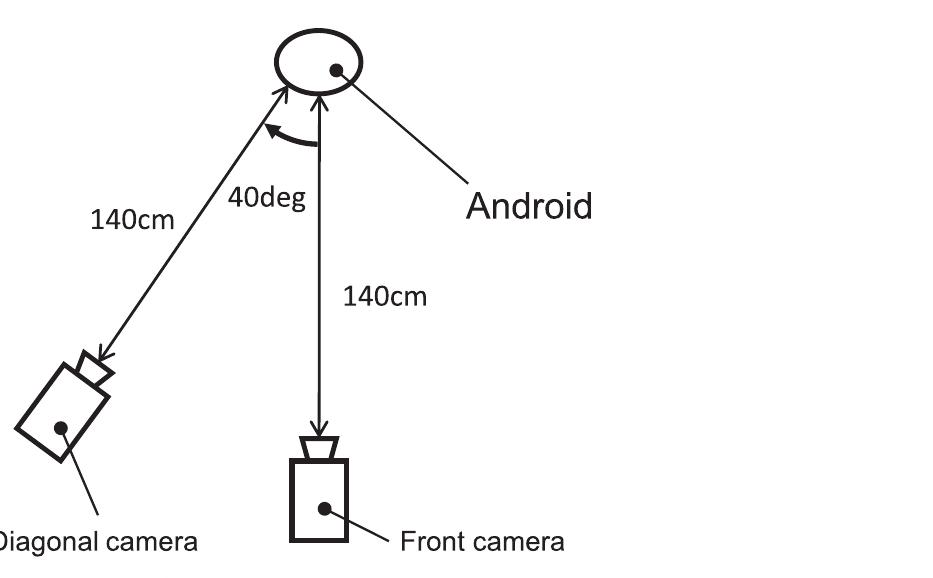
Fig 3. An overview of shooting